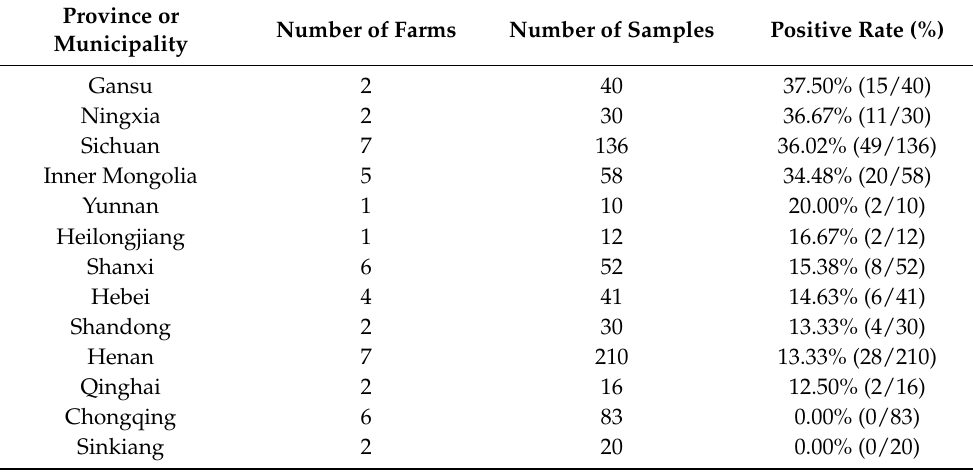
Table 1. Prevalence of BRSV in nasal swab samples from different provinces or municipalities of